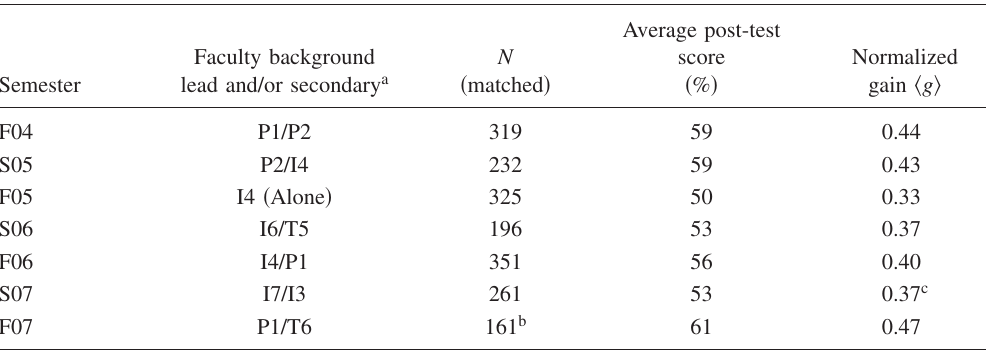
TABLE II. Summary of BEMA scores over seven semesters of data collection. All semesters shown used tutorials in recitation. The standard error of the mean for this table is very close to those in Table I, 1%–2% on post-test, and roughly (cid:1) 0.02 for normalized gains.